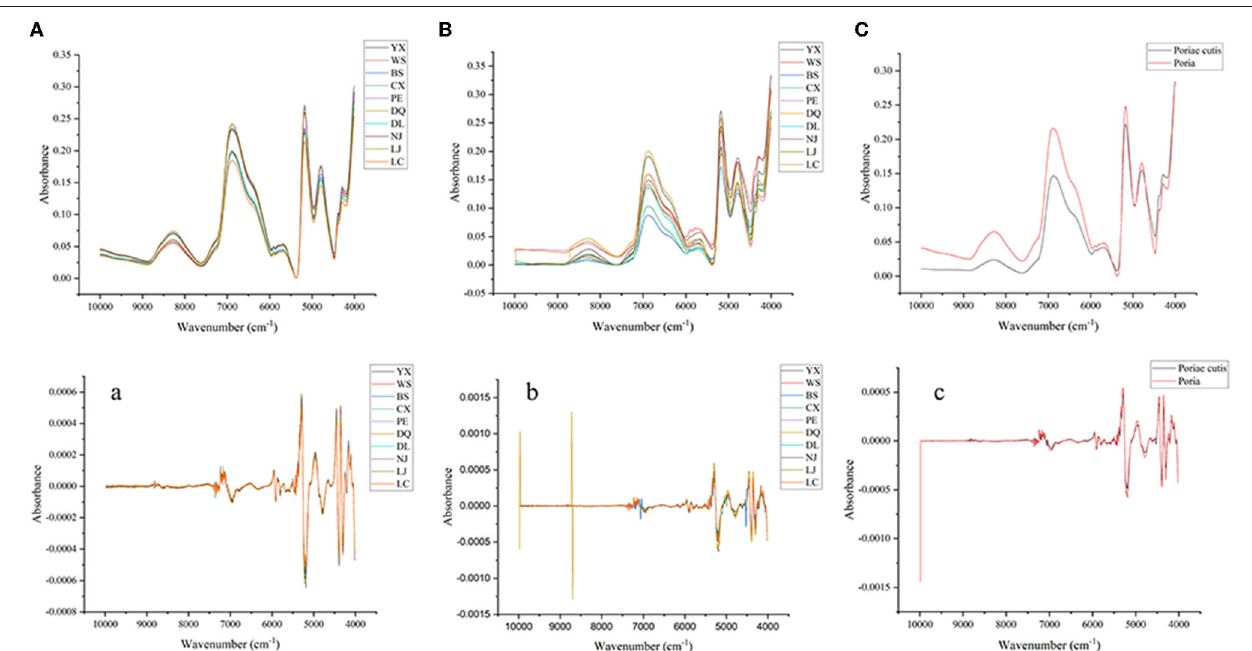
FIGURE 2 | Averaged raw and SD spectra of W. cocos . (A and a) Different regions of Poria ; (B and b) Different regions of Poriae cutis; (C and c) Different